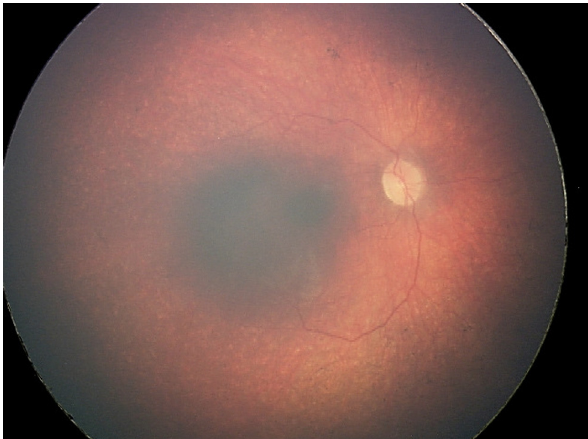
Figure 2: The girl with Cohen syndrome – note thick hair and eye - brow, abnormalities of the palpebral fi ssures ( downslanting and almond - shaped palpebral fi ssures ) .